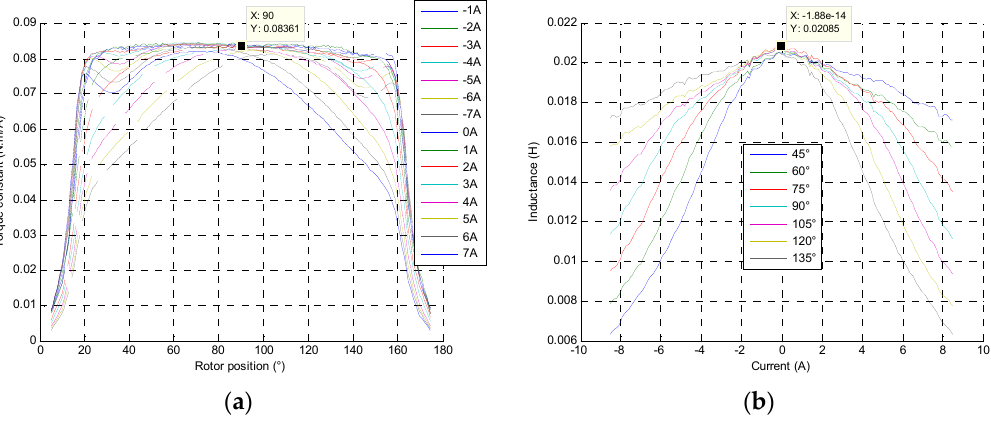
Figure 13. ( a ) Constant torque evolution at each rotor position and − 7 A to 7 A current of the direct drive actuator at 25 °C; ( b ) Inductance coil at each rotor position and current.